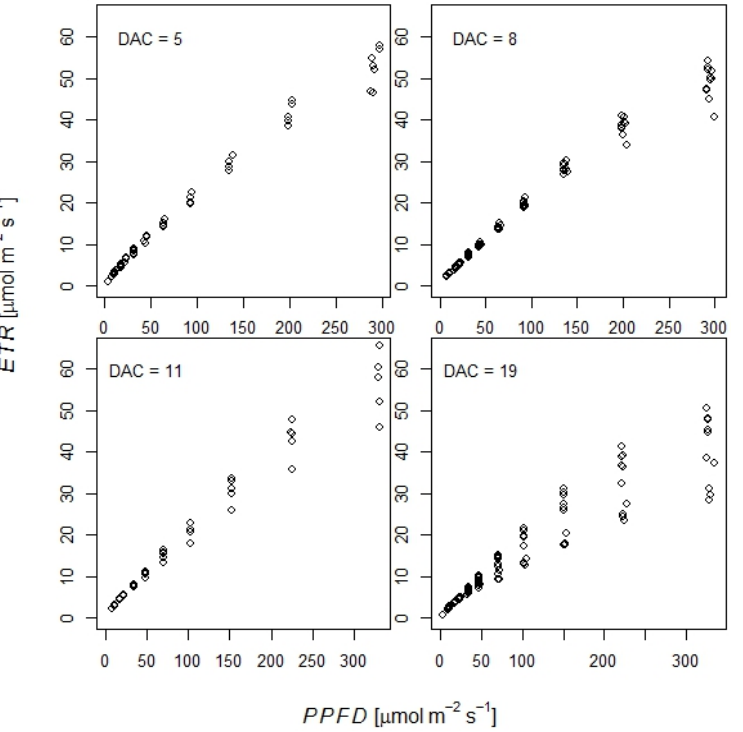
Figure 4. Response of electron transport rate (ETR) to Photosynthetically active Photon Flux Density (PPFD) of the durum wheat variety Claudio at 5, 8, 11 and 19 days after cutting (DAC), respectively